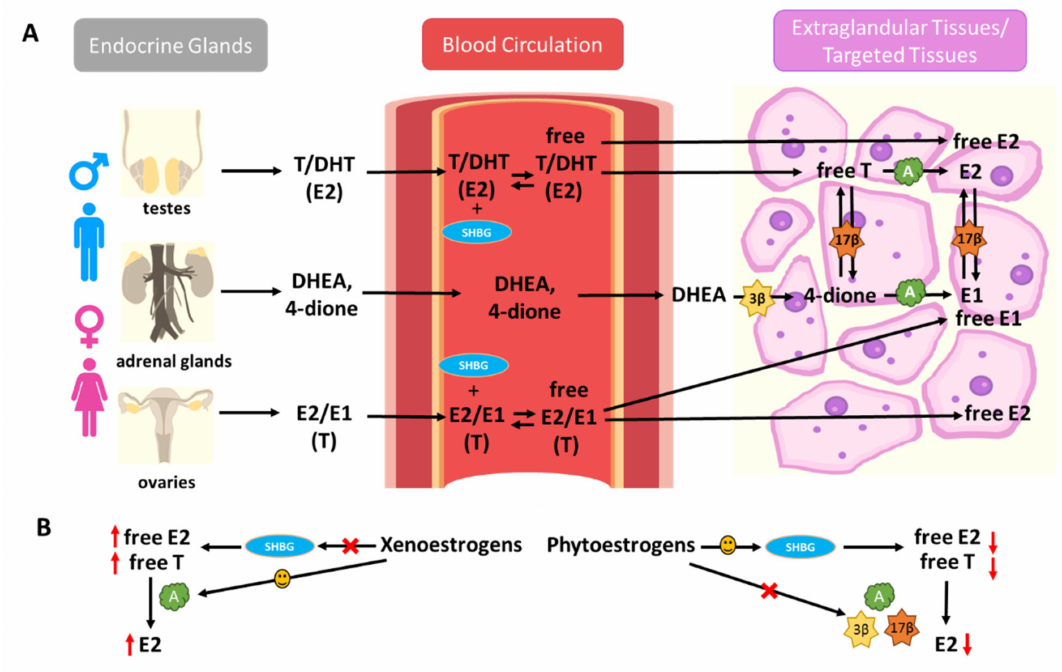
Figure 1. Xenoestrogens and phytoestrogens modify endogenous estrogen bioavailability and formation. ( A ) Endogenous estrogens are produced by endocrine glands (ovaries, testes, and adrenal glands) and transported to endocrine-responsive tissues through blood circulation. Human sex hormone-binding globulin (hSHBG) is a high-affinity binding protein in the bloodstream for endogenous estrogens, modulating the bioactivity of estrogens by limiting their diffusion into target tissues and cells. Extra-glandular tissues can also synthesize estrogens from adrenal dehydroepiandrosterone (DHEA) and androstenedione (4-dione) by steroidogenesis enzymes, such as aromatase (CYP19) and 3beta- and 17beta-hydroxysteroid dehydrogenases (3 β -HSDs and 17 β -HSDs). (B ) Xenoestrogens and phytoestrogens can modify the bioavailability of circulating endogenous estrogens by interfering with hSHBG binding. Xenoestrogens can also disrupt extra-glandular estrogen formation via interruption of steroidogenesis enzymes (A, aromatase, 3 β , 3 β -HSDs, and 17 β , 17 β -HSDs). Xe- noestrogens are more likely to displace endogenous E2 from hSHBG binding sites, enhance E2 formation by inducing the steroidogenesis enzyme expressions, such as aromatase, consequently promoting the estrogenic responses in humans. However, phytoestrogens may lead to a decrease in plasma E2 levels via interaction with hSHBG levels and interruption of estrogen